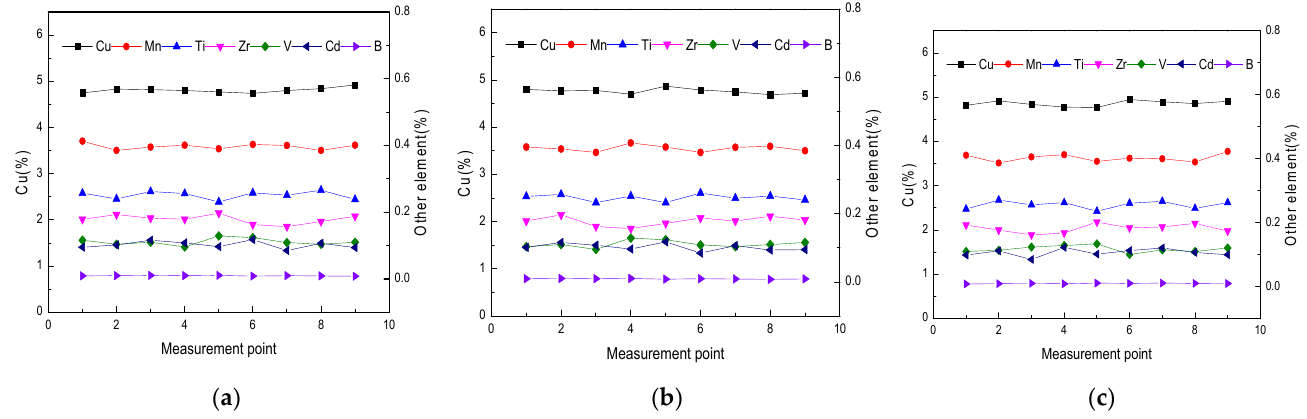
Figure 3. Chemical composition of ZCL205A alloy deposits manufactured with different deposition processes. ( a ) Macro-distribution of elements in the deposit prepared using the CMT process; ( b ) macro-distribution of elements in the deposit prepared using the CMT and Pulse process; ( c ) macro-distribution of elements in the deposit prepared using the CMT Pulse and Advanced